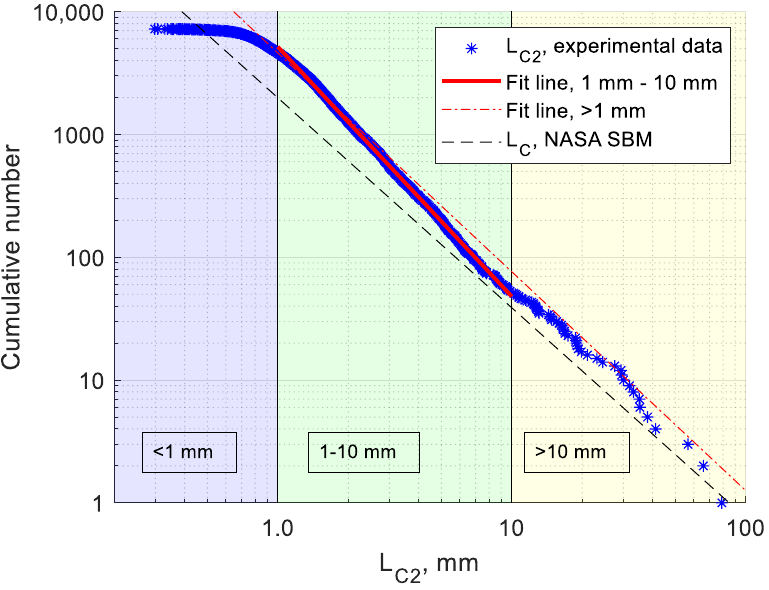
Figure 11. Comparison of experimental bi-dimensional characteristic length fitting lines for fragments larger than 1 mm (red dash-dot line) and in the range between 1 and 10 mm (solid red line) [47].